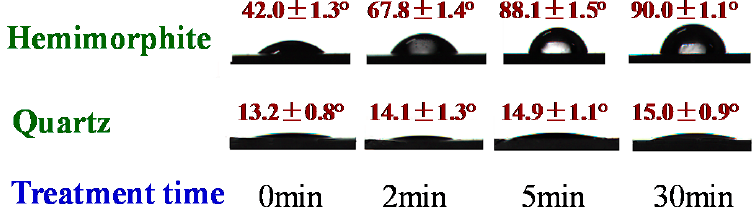
Figure 4. Contact angles of hemimorphite or quartz surfaces as a function of treatment time at 5 × 10 − 5 mol·L − 1 HDDPA.